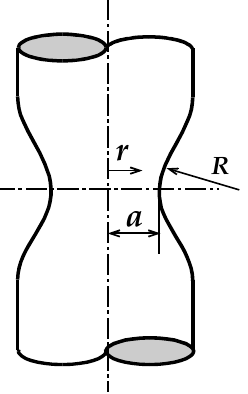
Figure 15. Scheme of the wire’s necking during a tensile test. The curvature radius of the necking surface R was measure by means of a profile projector (NIKON V-12B, Tokyo, Japan). The average values obtained were 26.25 and 3.16 mm for the hot rolled steel E0 and the prestressing steel E7, respectively. With these va-lues, and taking into account the Davidenkov and Spiridonova equations (2), it’s pos- sible to obtain the stress distribution ( σ , σ θ and σ ; being σ θ = σ ) along the wires net sec- z r r tion in the previous instants to final fracture occurs. Such stress distribution is showed in Figure 16 for the case of the steels E0 and E7. The stress distribution is equal in both steels and for all considered variables, being maximum in the center (longitudinal wire axis, r = 0) and minimum in the periphery of the wires (deepest point in necking external surface, where r = a ). The values are greater for the case of prestressing steel wires.